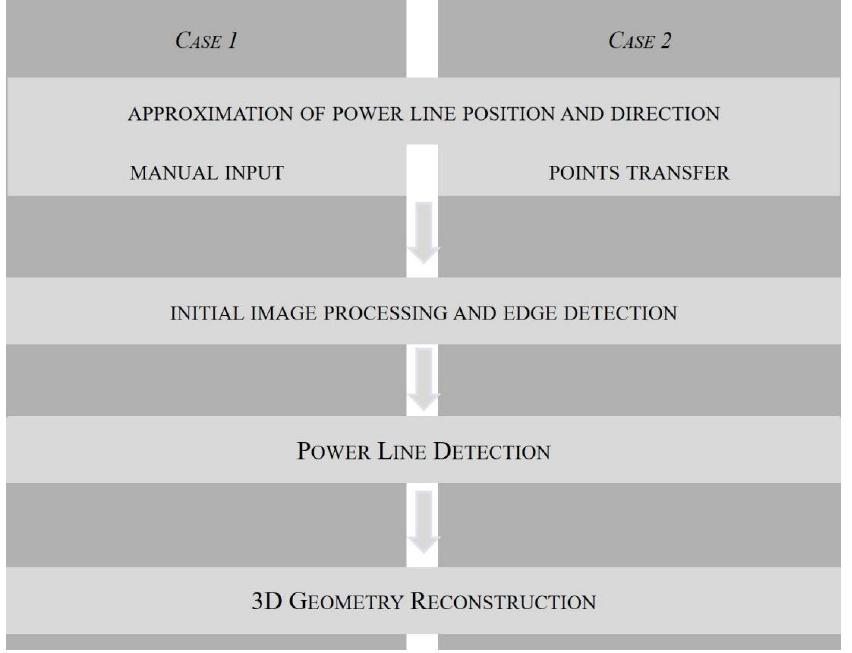
Figure 6. Outline of power line detection process.